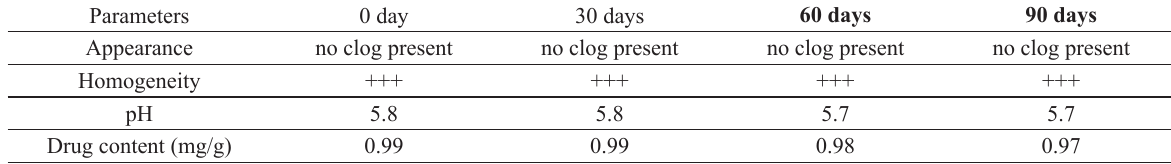
Stability study for Optimized Formulation